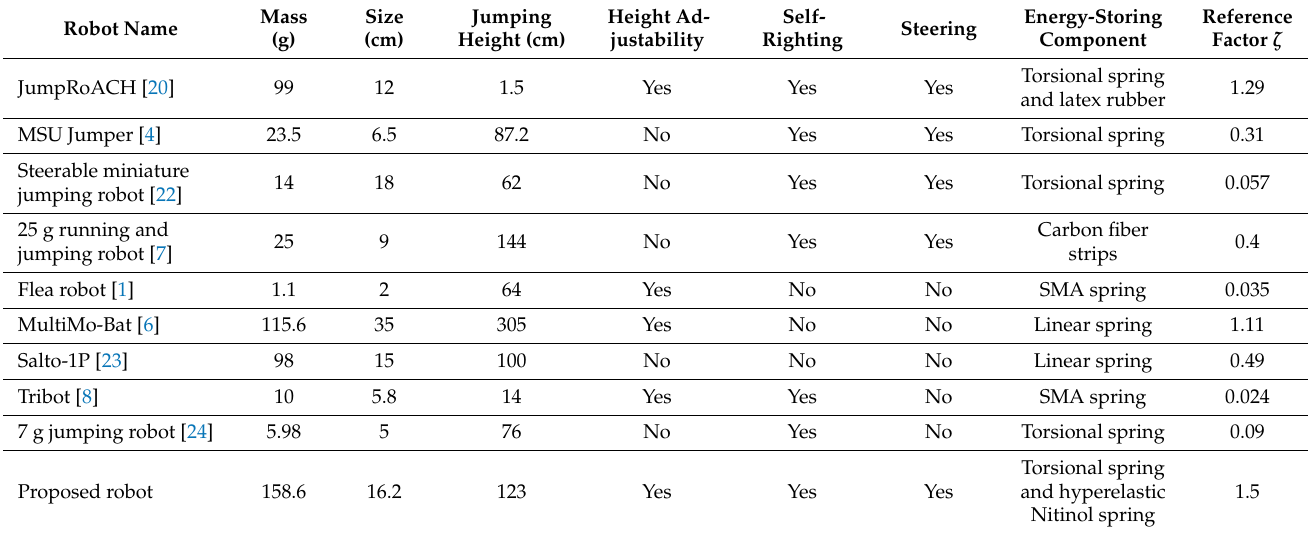
Table 2. Performance comparison of jumping